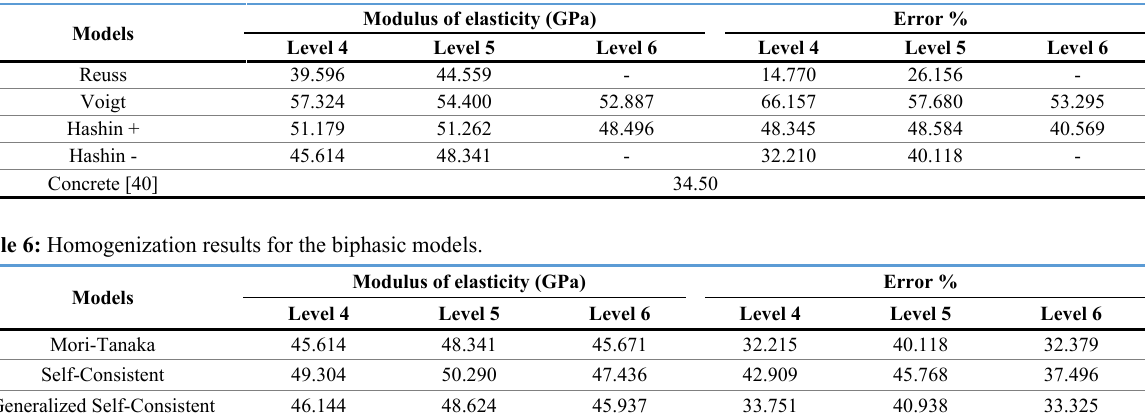
Table 5: Homogenization results for the limit models.